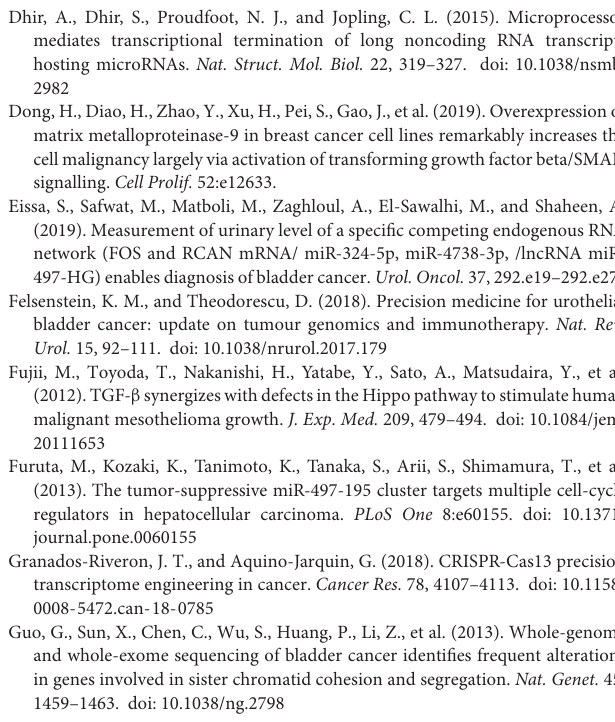
Supplementary Figure 1 | Knockdown efficiency of MIR497HG with three diferent siRNA. RT-qPCR assays showed no significant change of MIR497HG in 3 siRNAs transfected cells. Supplementary Figure 2 | MIR497HG suppressed T24 cell growth, migration and invasion in vitro . The CCK-8 assay (A) and colony formation assays (B, C) showed that MIR497HG overexpression repressed T24 cell proliferation. Wound healing assays (D, E) and transwell assays (F, G) suggested that overexpression of MIR497HG significantly inhibited migratory and invasive activity of T24 cells. Data are shown as mean ± SD. n = 3 for technical replicates. ∗∗ P < 0.01 and ∗∗∗ P < 0.001. Supplementary Figure 3 | Expression analysis of selected genes after miR-497 or miR-195 overexpression. Birc5 (A) , CCND1 (B) , Smad3 (C), and Yap (D) mRNA levels were detected by RT-qPCR in miR-497 mimic, miR-195 mimic, and mimic-ctrl transfected cells. Data are shown as mean ± SD. n = 3 for technical replicates. ∗∗ P < 0.01 and ∗∗∗ P < 0.001. Supplementary Figure 4 | RT-qPCR suggested that the expression of MIR497HG was no changed after knock down of E2F6. ∗∗∗ p < 0.001. Supplementary Table 1 | Sequences for cloning, site directed mutagenesis, ChIP-qPCR and RT-qPCR in this work. Supplementary Table 2 | KEGG pathway enrichment analysis showed that miR-195/497 cluster putative targets involve in different biological pathways. Supplementary Table 3 | The binding of transcription factor and promoter of MIR497HG was predicted by JASPAR